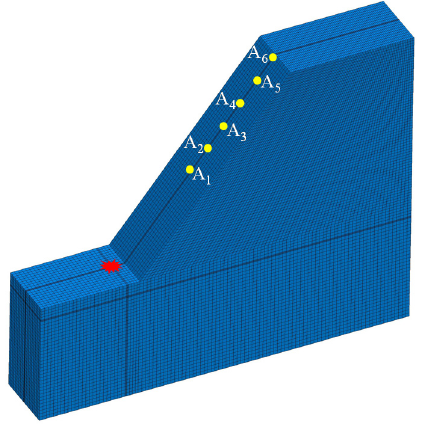
Figure 7. The feature points A 1 –A 6 .